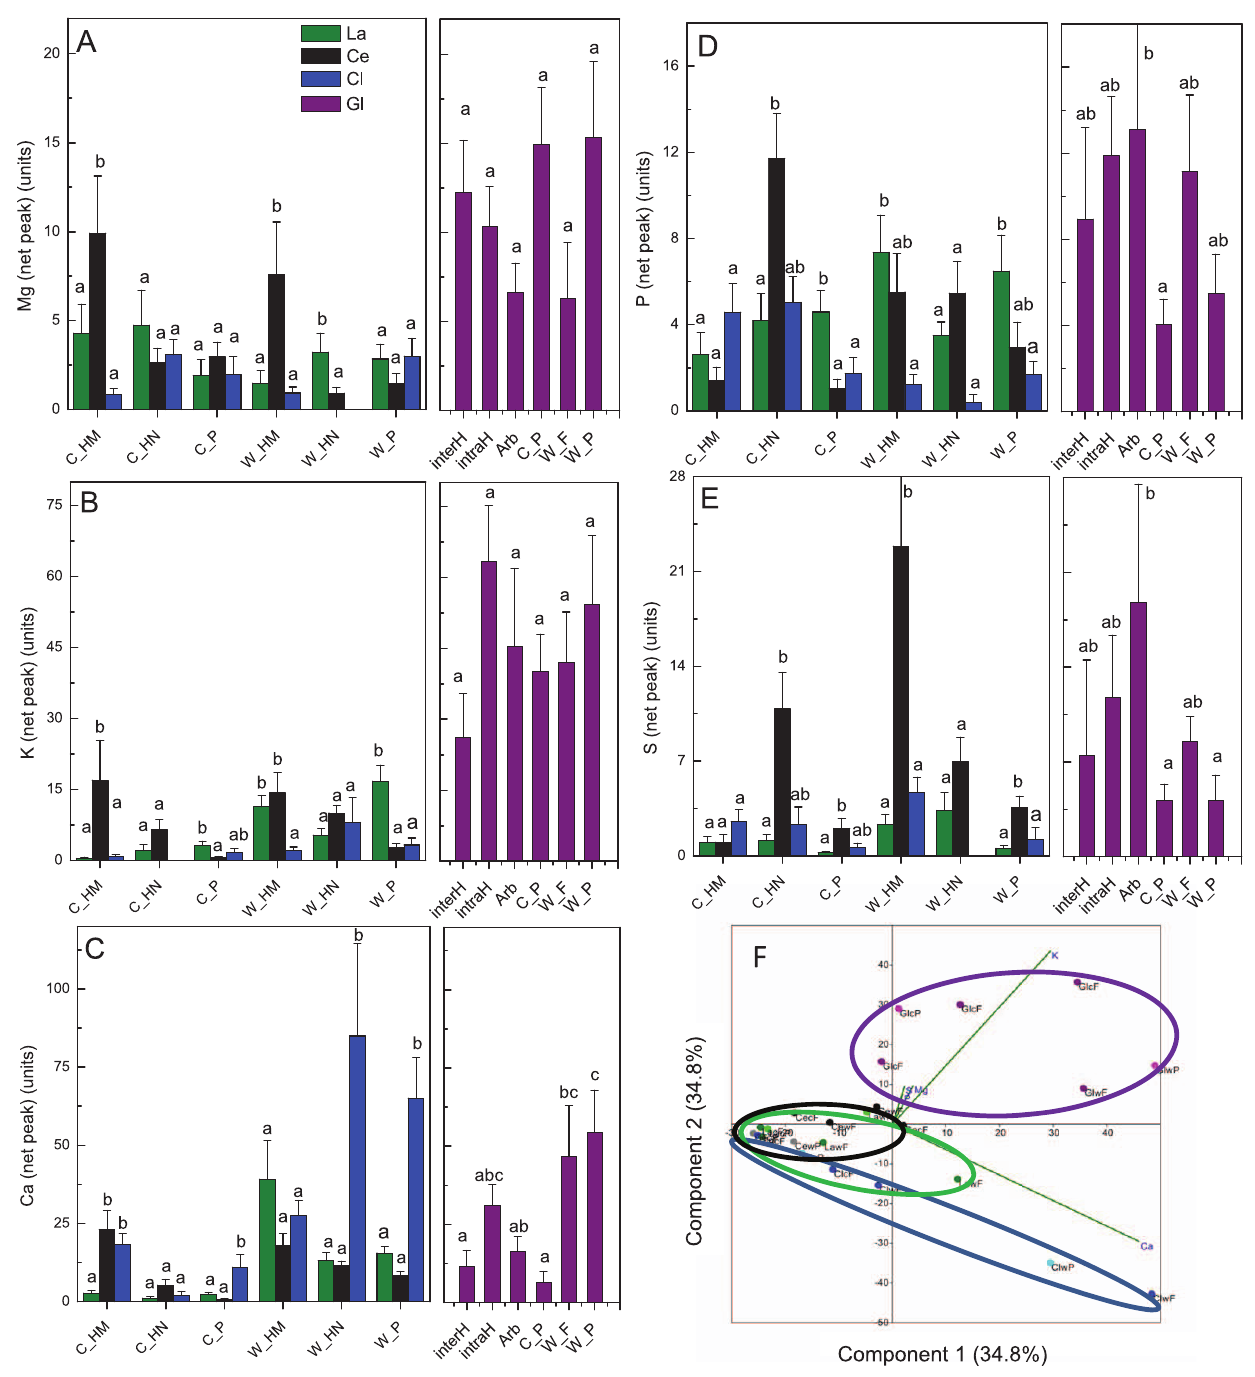
Fig. 4. Subcellular nutrient element levels in different subcellular structures of mycorrhizal roots associated with different mycorrhizal taxa [(A) Magnesium, (B) Potassium, (C) Calcium, (D) Phosphorus, (E) Sulphur] and principle component analysis (F). Data indicate means (n $ 20 to 60 ¡ SE). Different letters for a given structure (EcM) or between the different compartments (AM) indicate significant differences at P # 0.05. La 5 Lactarius subdulcis, Ce 5 Cenococcum geophilum, Cl 5 Clavulina cristata, Gl 5 Glomus sp., C 5 cell, W 5 Wall, HM 5 Hyphal mantle, HN 5 Hartig net, InterH 5 intercellular hyphae, intraH 5 intracellular hyphae, Arb 5 arbuscules, F 5 fungus, P 5 plant.